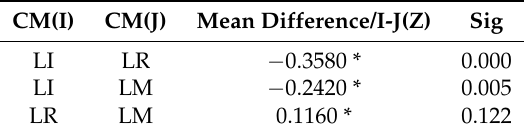
Table 3. Post hoc test for different combinations of coding parameters with LSD